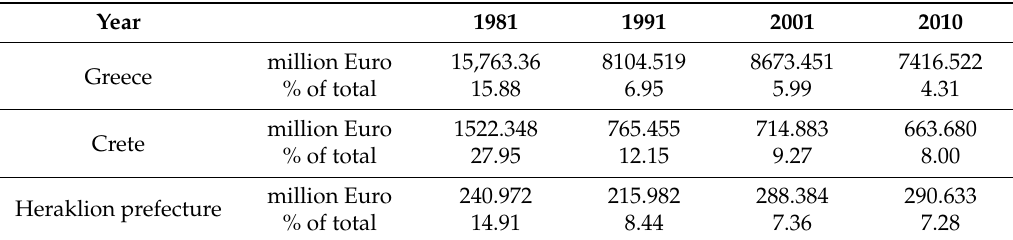
Table 3. Gross Value Added of agriculture of indicative years at constant (2005)